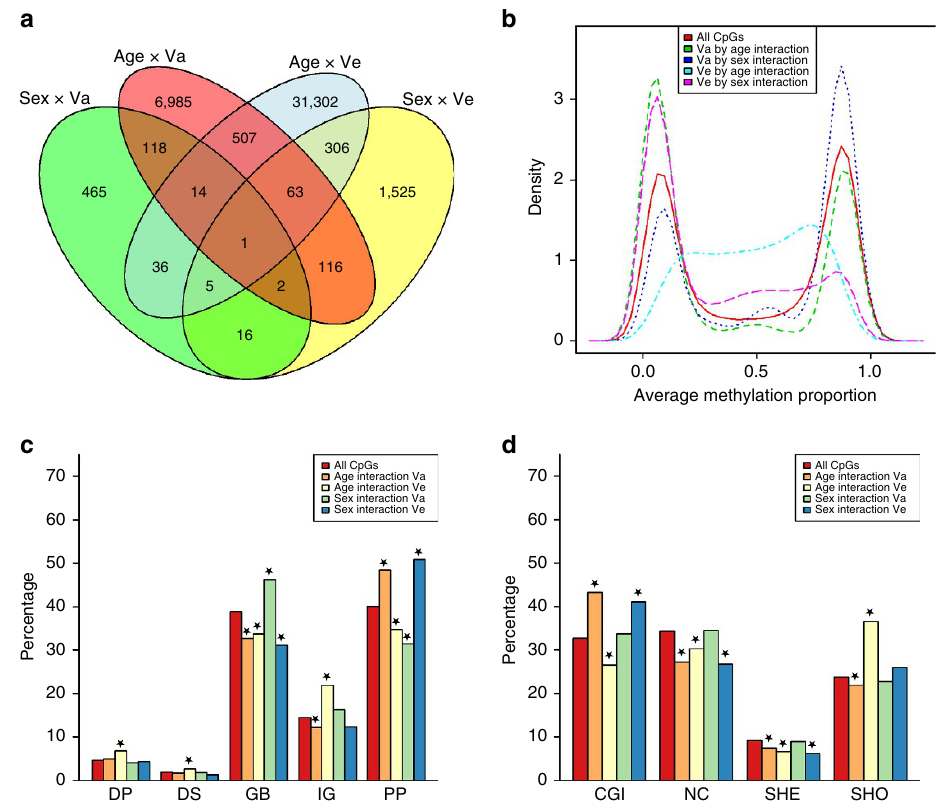
Figure 6 | Characteristics and overlap of sites showing interaction between age or sex and genetic or environmental variance. ( a ) Venn diagram of the number of CpGs with significant interaction between sex and genetic variance (Sex (cid:2) Va), between sex and unique environmental variance (Sex (cid:2) Ve), between age and genetic variance (Age (cid:2) Va) and between age and unique environmental variance (Age (cid:2) Ve). ( b ) Density plot of CpGs with significant interaction effects. ( c ) Distribution of methylation sites with interaction effects relative to genes: DP, distal promoter; DS, downstream region; GB, gene body; IG, intergenic; PP, proximal promoter. ( d ) Distribution of methylation sites with interaction effects in relation to CpG density: CGI, CpG island; NC, non-CGI; SHE, CpG island shelf; SHO, CpG island shore. Asterisks denote significant enrichment or depletion ( a ¼ 4.27 (cid:2) 10 (cid:3) 4 , w 2 -test). Results are based on data from 2,603 individuals.